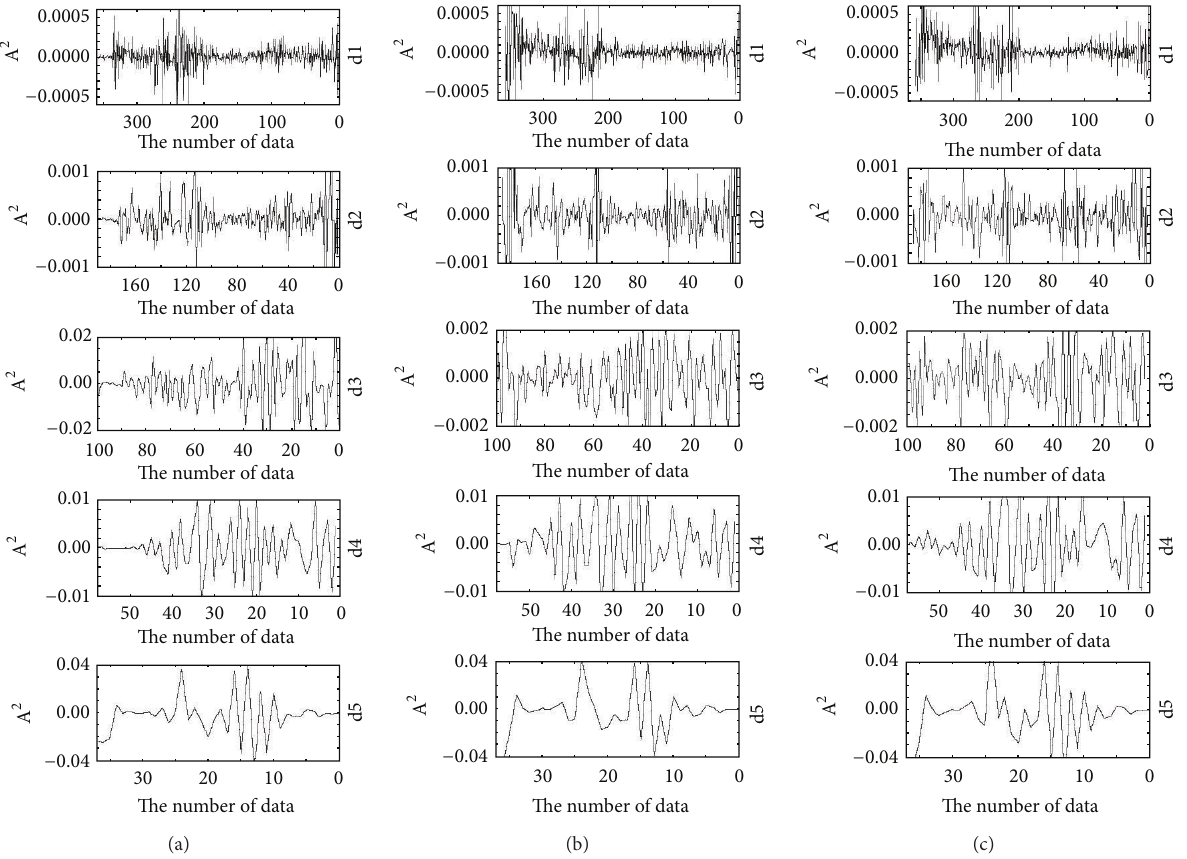
Figure 3: DWT of the Radix Bupleuri and its unofficial varieties. (a) Radix Bupleuri ; (b) root of the Bupleurum smithii Wolff; (c) root of the Bupleurum bicaule